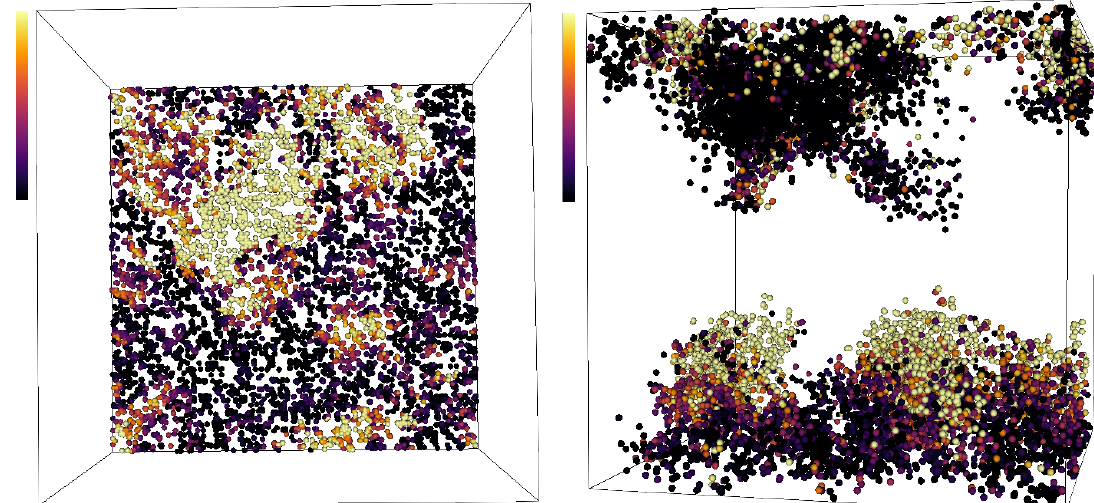
Figure 7. Visualization of particles in a slice of the simulation volume determined by the first three grid spaces in the z -direction in simulation HC1: two-dimensional visualization at the initial time point ( left ), and three dimensional visualization as the same particles trace the evolution of the evolving convective flow structures ( right ). Particles are colored by the instantaneous local Nusselt number that they experience between zero and 10 4 , with dark colors indicating a low Nusselt number and bright colors indicating a high Nusselt